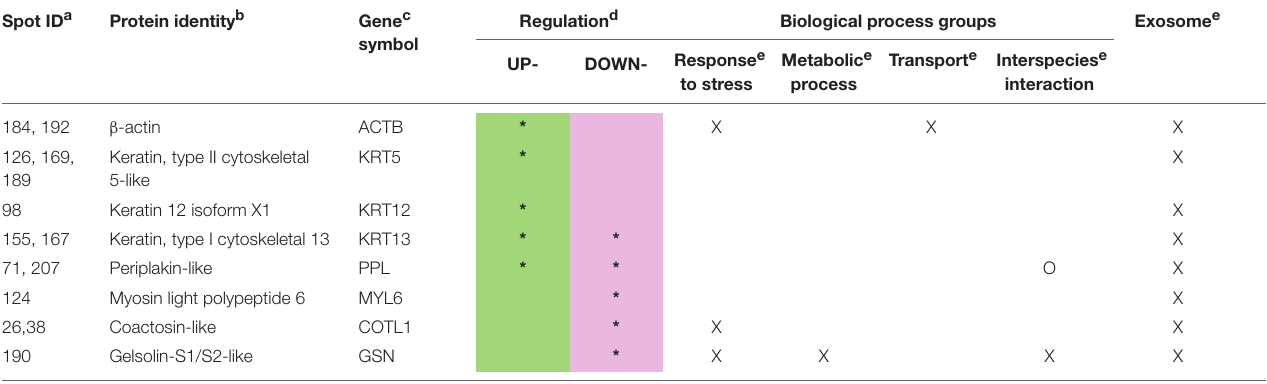
a Spot number from Supplementary Figure 1 (where green spots are over-expressed and pink spots were under-expressed) and the corresponding spot ID in Tables 1 , 2 . b Protein identities were supplied by the Mascot Search Results (Matrix science). Further details of search conditions in Material and Methods section. c Gene symbol of each protein were obtained from the Genecards database search process (http://www.genecards.org). d Up- or Down- protein regulation in cold condition. The intensities of each protein and statistical analysis Student T-test (p < 0.05) are shown in Table 1 . e Classification of proteins into different categories based on Gene Ontology enrichment analysis (GO) using UniprotKB number (shown in Table 1 ). Related to Biological process GO: Response to stress (GO:0006950, p = 7.05e-06); Single-organism metabolic process (GO:0044710, p = 3.85e-02); Transport (GO:0006810, p = 2.39e-02); Interspecies interaction betweenorganisms(GO:0044419,p = 2.22e-05).AnadditionalclusterofCellularcomponentcategorieshasbeenadded:Extracellularvesicularexosome(GO:0070062,p =